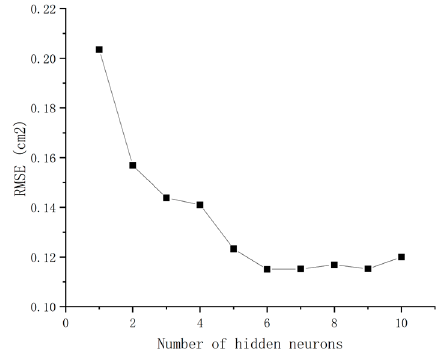
Figure 6. Hidden layer parameter optimization.